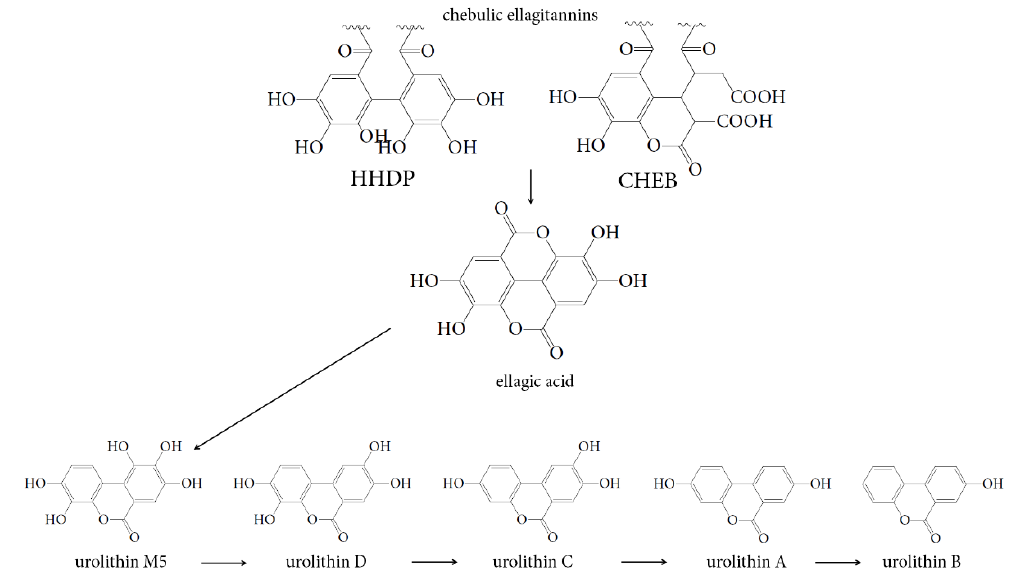
Figure 10. Proposed pathway of chebulic ellagitannins transformation by intestinal bacteria. HHDP—hexahydrodiphenoyl moiety, CHEB—chebuloyl moiety. 18